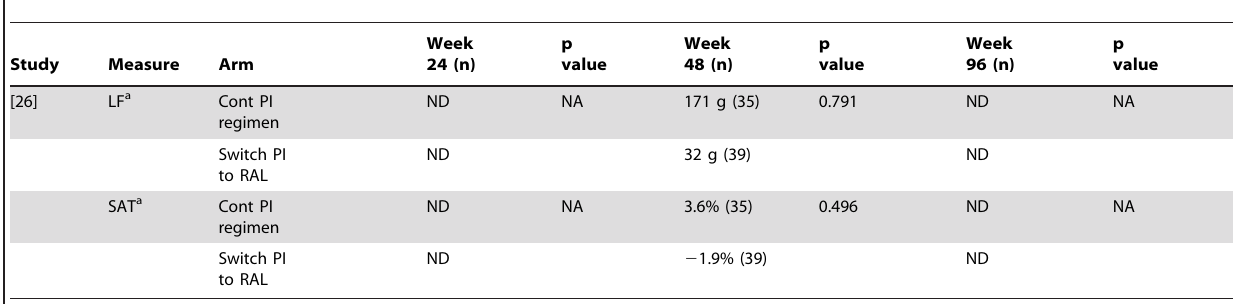
Table 21. Switching studies: change from baseline in limb fat (LF) on DEXA scan and subcutaneous adipose tissue (SAT) on CT scan: PI versus